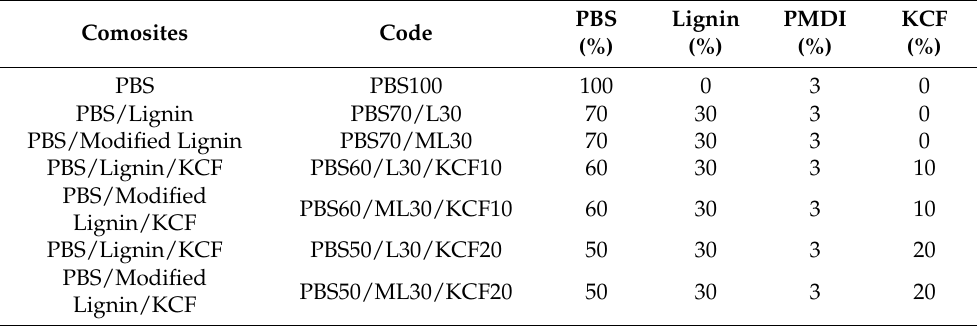
Table 1. PBS composites formulation and